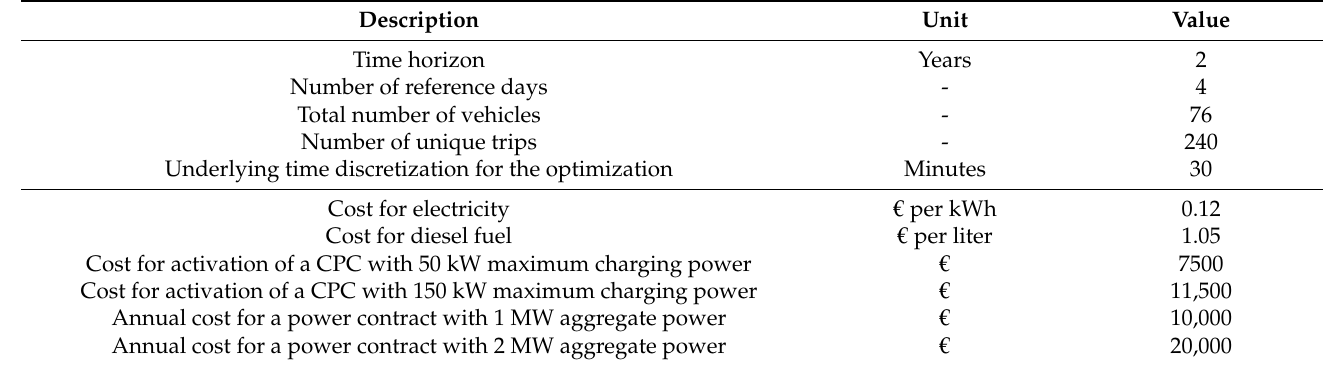
Table 3. Reference data for the optimization of the use-case of the public transport operator of